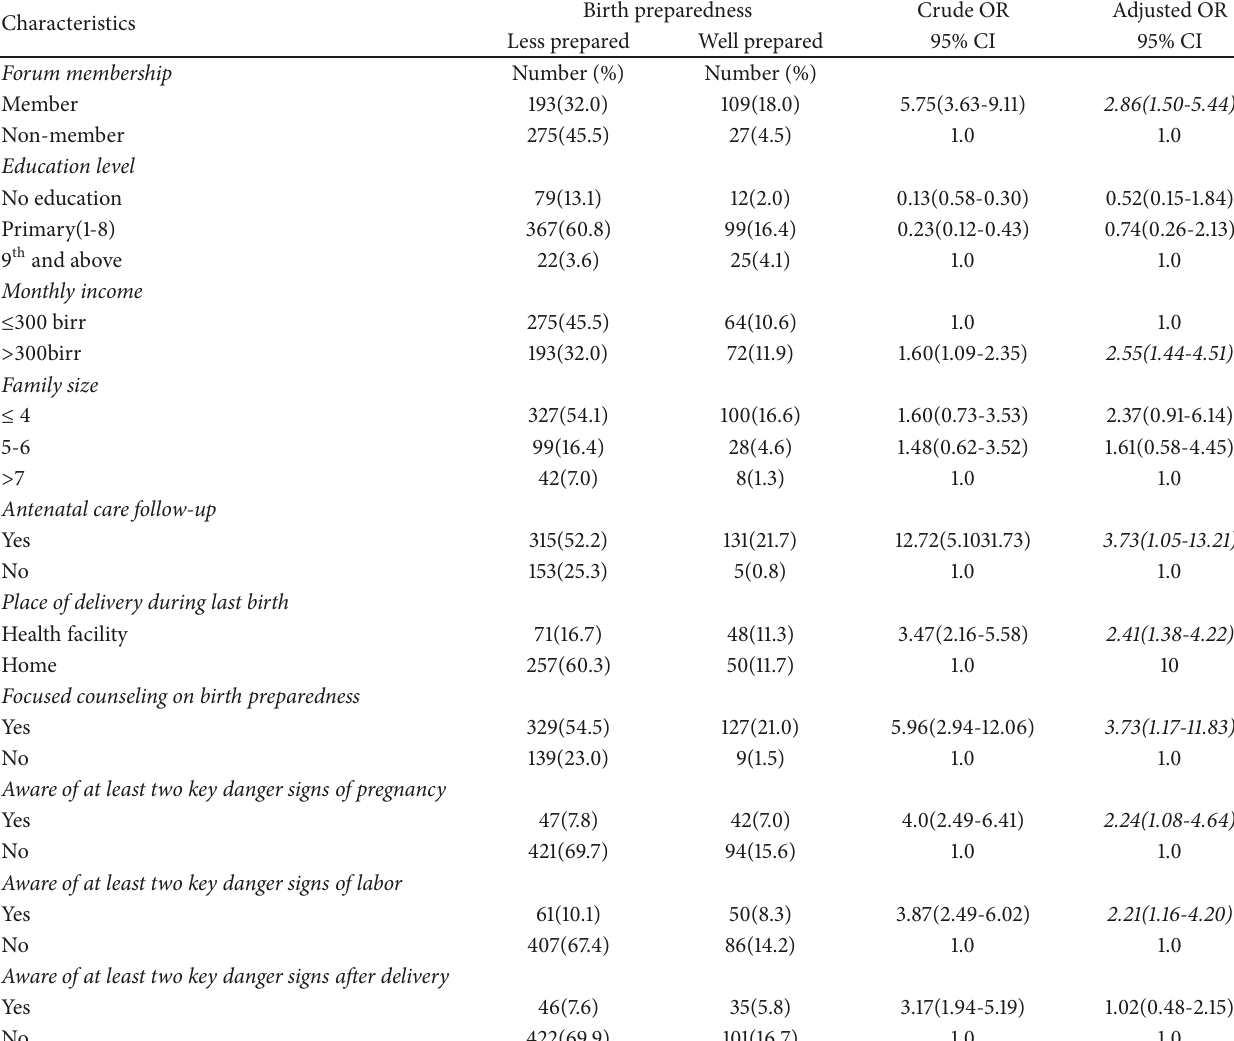
Table 6: Factors influencing birth preparedness adjusted for confounding variables, in Dale District, 2015.